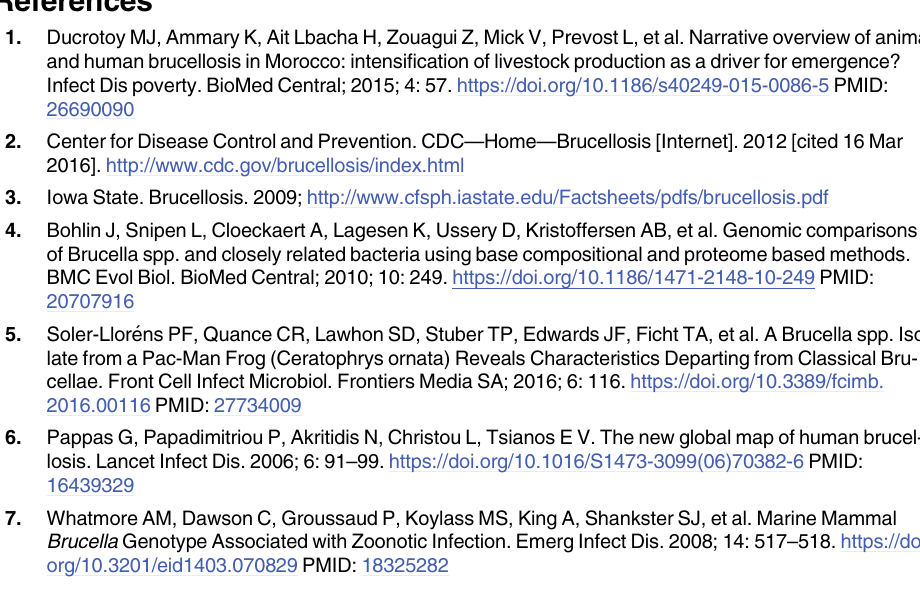
S4 Table. Significant differences between B . suis 1330 compared to BN. (+ = statistically higher internal bacterial loads, − = statistically lower internal bacterial loads, 0 = no statistical